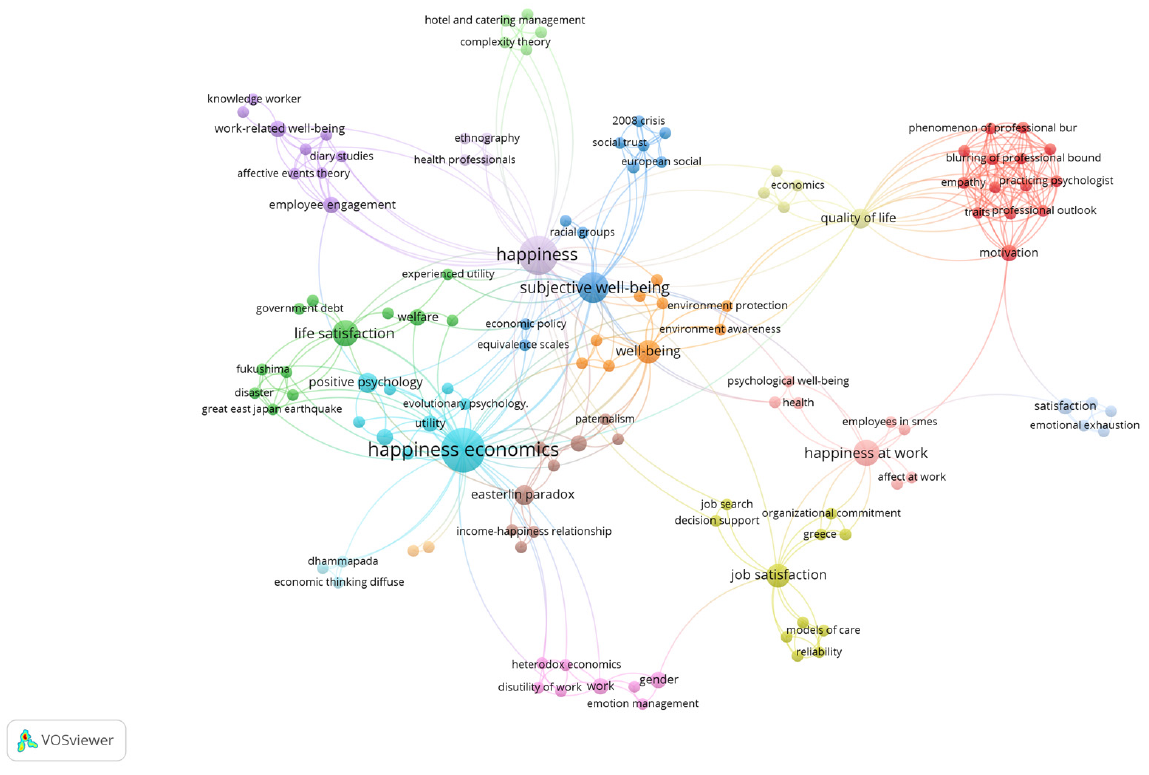
Figure 5. Keyword co-occurrence maps; period: